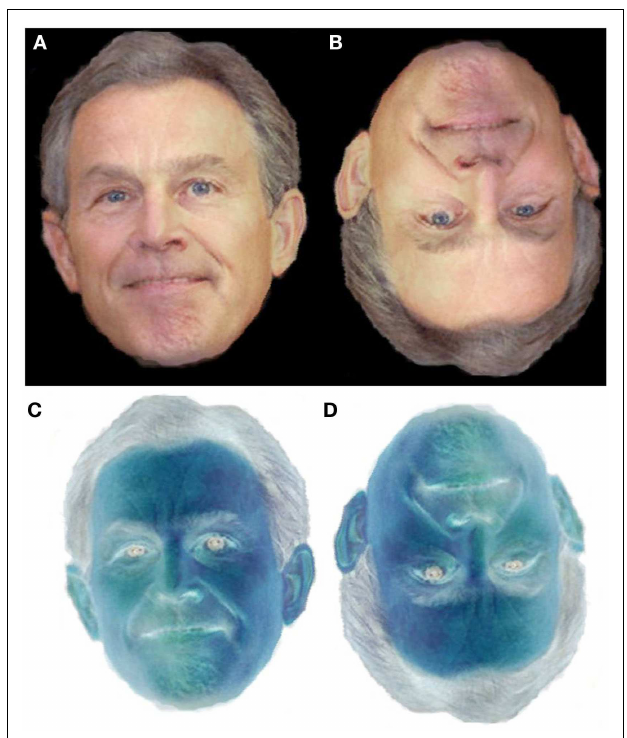
FIGURE 1 | Examples of the stimuli used in this Experiment. (A) The unaltered 50% midpoint. (B) The inverted 50% midpoint. (C) The negated 50% midpoint. (D) The inverted and negated 50%